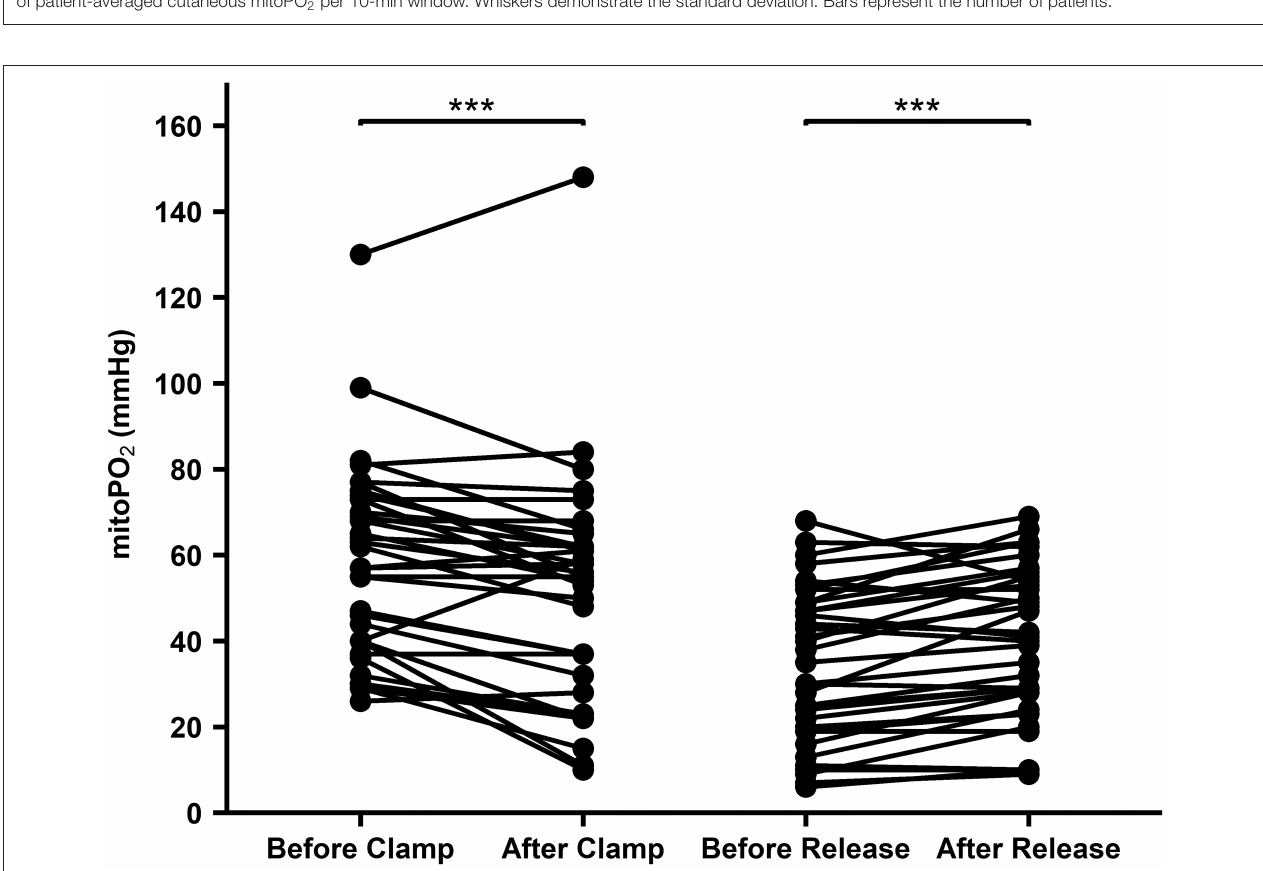
FIGURE 5 | Cutaneous mitoPO 2 values before and after aortic clamping and cutaneous mitoPO 2 values before and after the release of aortic clamping. WU test paired p <